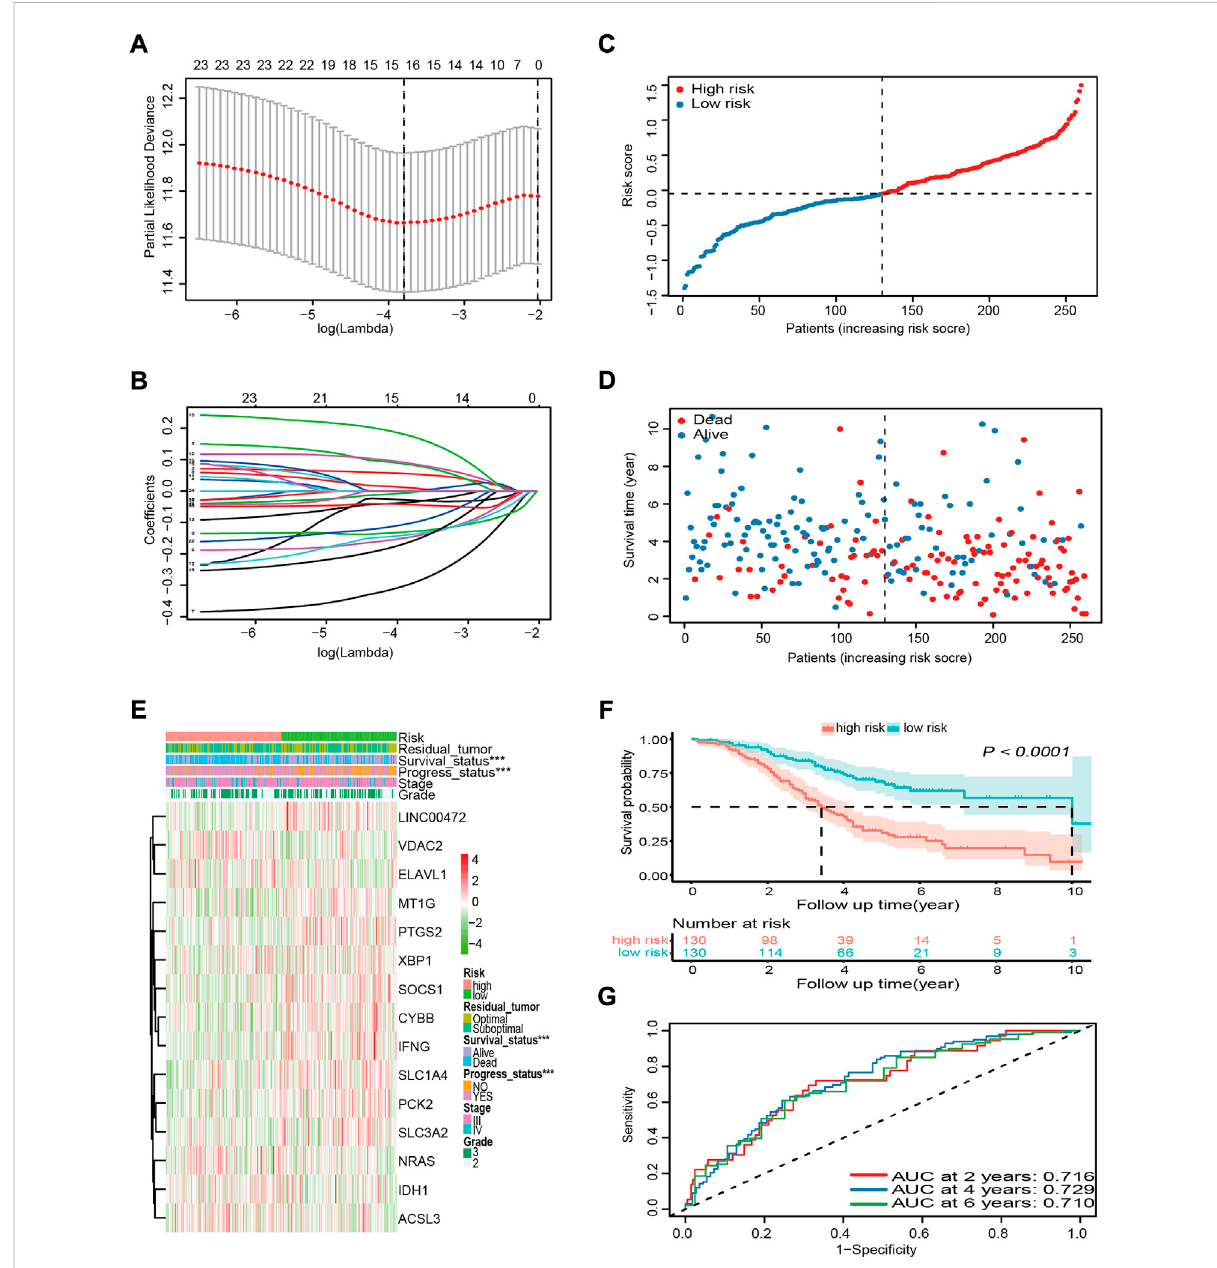
FIGURE 3 Construction and prognostic analysis of the 15-FRG prognostic signature based on the GSE32062 cohort data. (A) Penalty parameter λ optimization using the LASSO algorithm, with 10-foldcross validation.The optimal values using minimum criteria (left)and the one standard error of the minimum criteria (right) are indicated by dotted vertical lines. (B) LASSO coef fi cient pro fi les of the 25 candidate genes. (C) Distribution and median values of the risk scores. (D) Distributions of survival time, survival status, and risk score. (E) Distributions of risk score, clinical characteristics, and gene expression panels. * p < 0.05; ** p < 0.01; *** p < 0.001. (F) Kaplan – Meier curves for OS in the different groups. (G) Time- dependent ROC curves and their AUCs verifying the prediction ef fi cacy of the risk score. FRG, ferroptosis-related gene; LASSO, least absolute shrinkage and selection operator; OS, overall survival; ROC, receiver operating characteristic; AUC, area under the